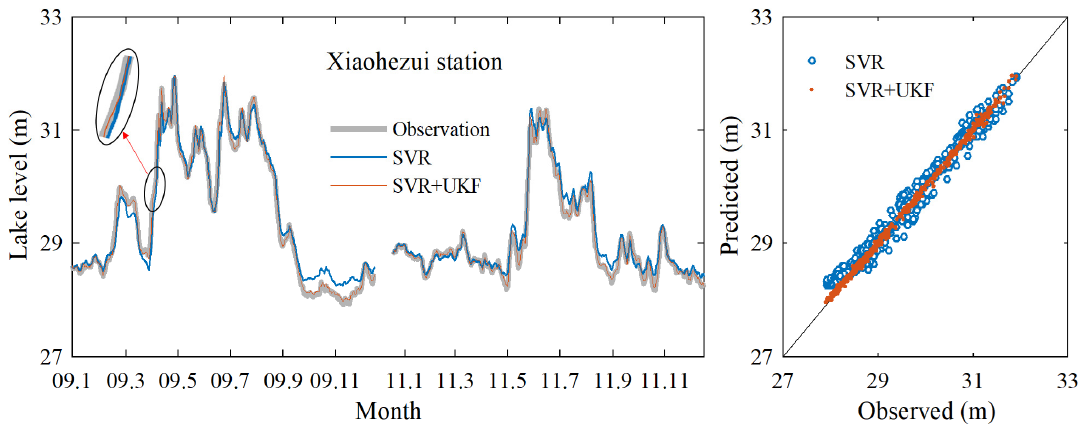
Figure 8. Comparisons between Xiaohezui water levels predicted with SVR and SVR+UKF.